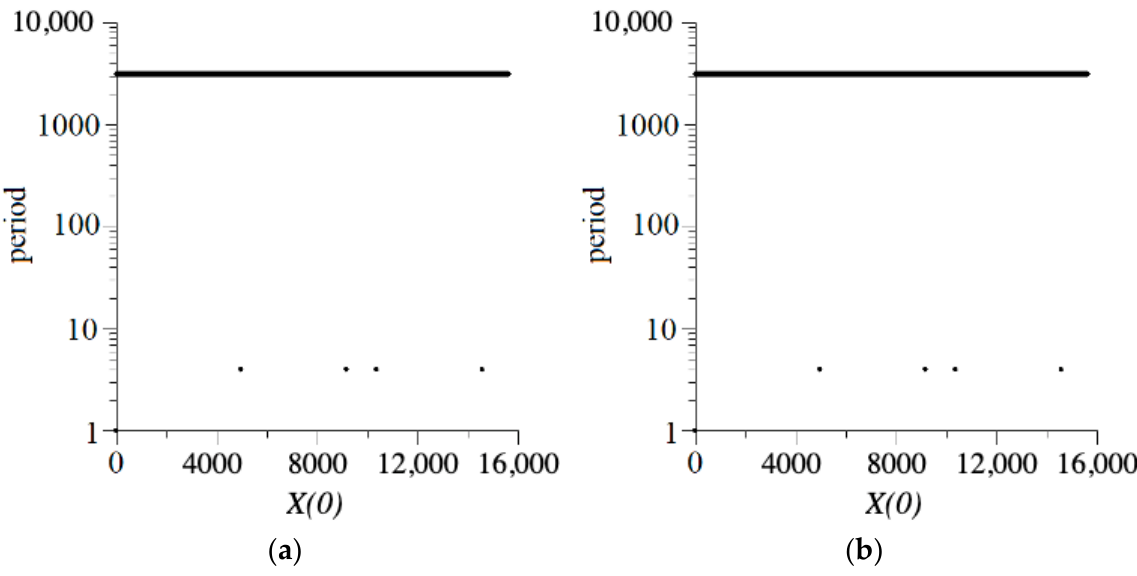
Figure 3 on a logarithmic scale shows the dependence of the repetition periods of the AFG pseudorandom sequence numbers from the initial values, X (0).